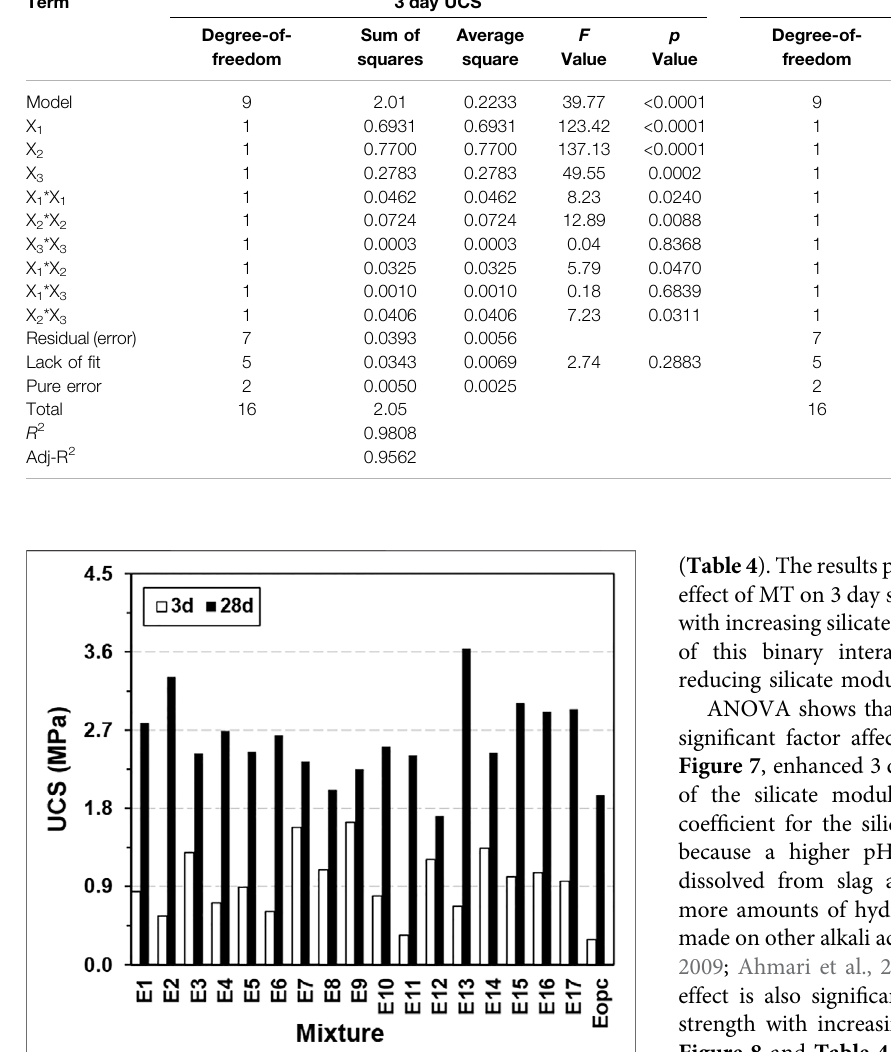
FIGURE 4 | Plots of UCS performance of 3- and 28 day cured CPB